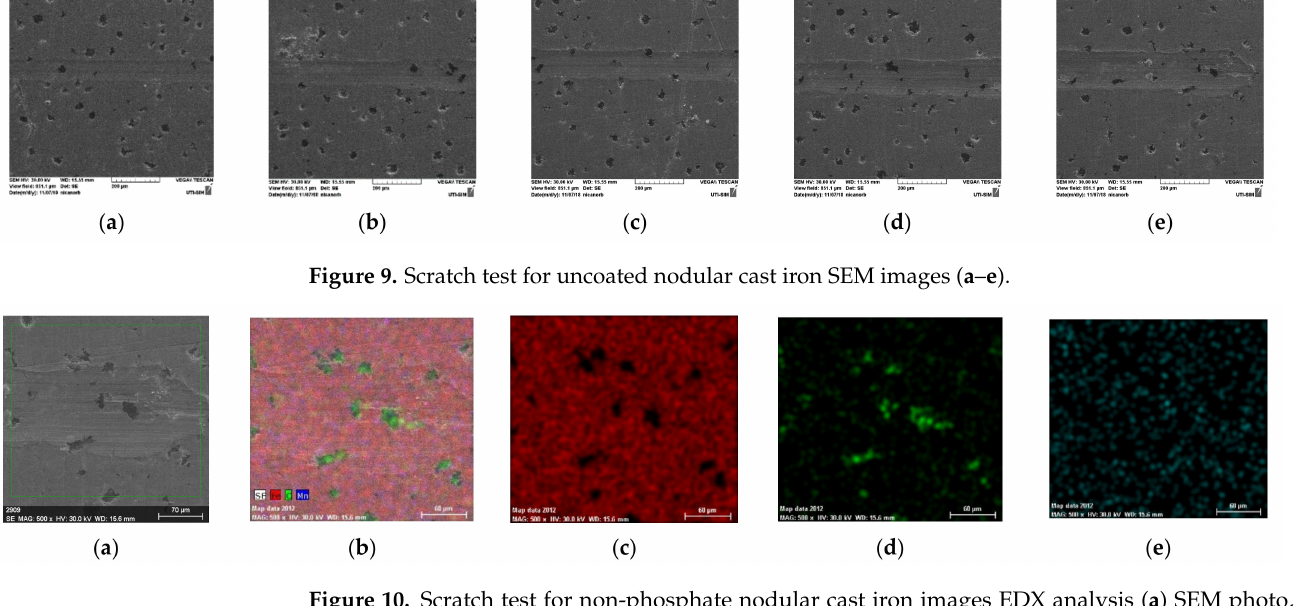
Figure 10. Scratch test for non-phosphate nodular cast iron images EDX analysis ( a ) SEM photo, ( b ) distribution of all elements, ( c ) distribution of Fe, ( d ) distribution of C, ( e ) distribution of Mn.